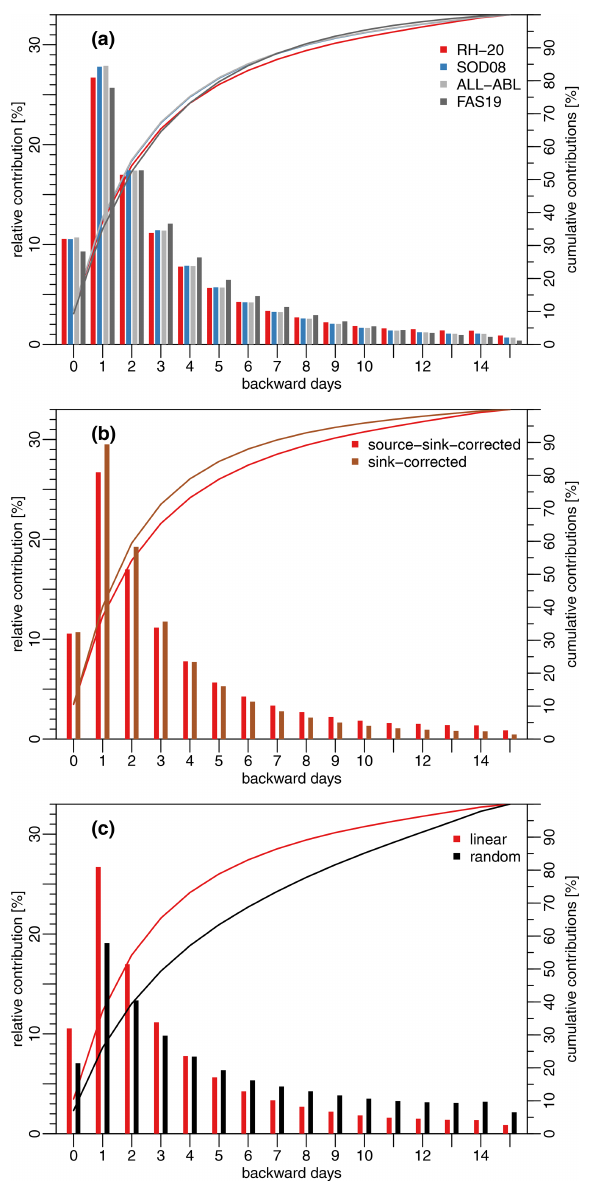
Figure 10. Relative (bars) and cumulative (lines) backward day contributions to precipitation (a) comparing the detection criteria, (b) illustrating the bias correction impacts, and (c) varying the attri- bution method, averaged over all three cities and the period 1980– 2016. The red bars and lines show the same setting (RH-20, em- ploying linear discounting and attribution, and source- and sink- corrected contributions) in all